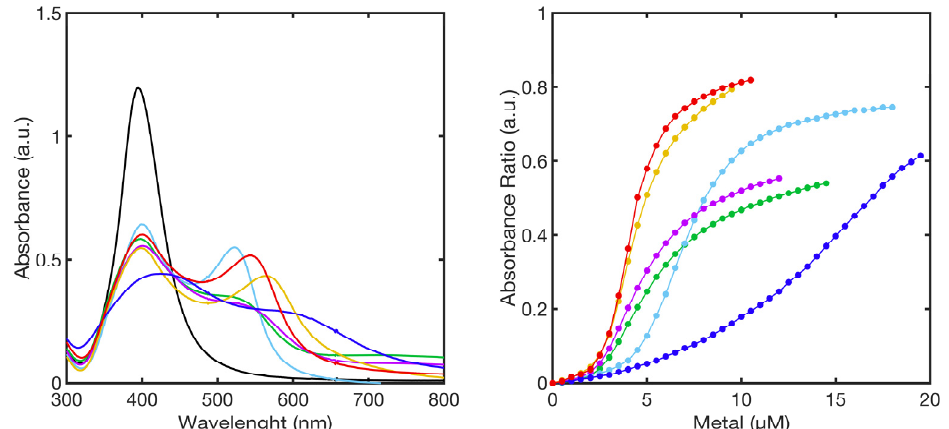
Figure 9. Superimposition of UV-Vis spectra of PL 1 -AgNPs@11MUA (black line) obtained at the highest concentration of metal ions ( left -panel), calibration curve showing the relationship between absorbance ratio and metal concentration used in the titrations ( right -panel). Ni 2+ (green line), Mn 2+ (blue line), Cu 2+ (red line), Zn 2+ (cyan line), Co 2+ (purple line), and Cd 2+ (yellow line).